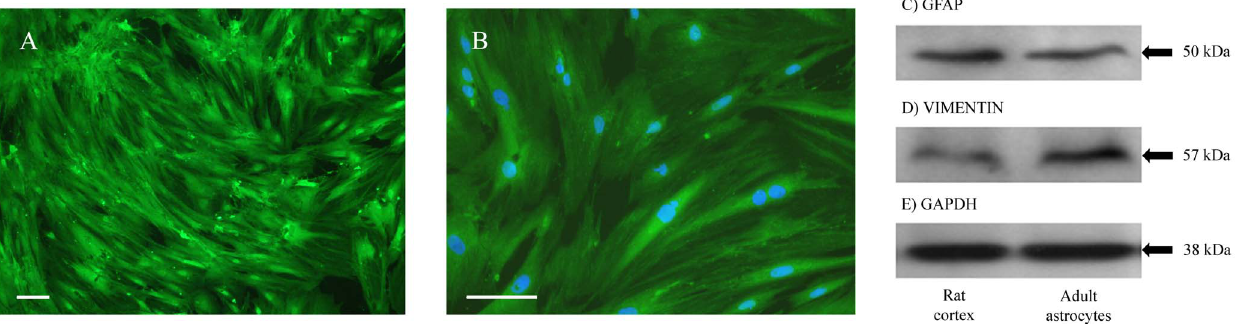
Figure 2. Adult astrocyte cultures present classical astroglial markers. ( A ) Astrocytes show intense immunolabeling for GFAP. ( B ) The cells were counterstained with DAPI (blue). Shown are the merged images only. The data are from 5 independent experiments. Scale bars: (A)=50 m m, (B)=100 m m. Representative immunoblot band of rat cortex homogenate and adult astrocytes for ( C ) GFAP, ( D ) vimentin, ( E ) GAPDH. N=5 for all immunoblot experiments.